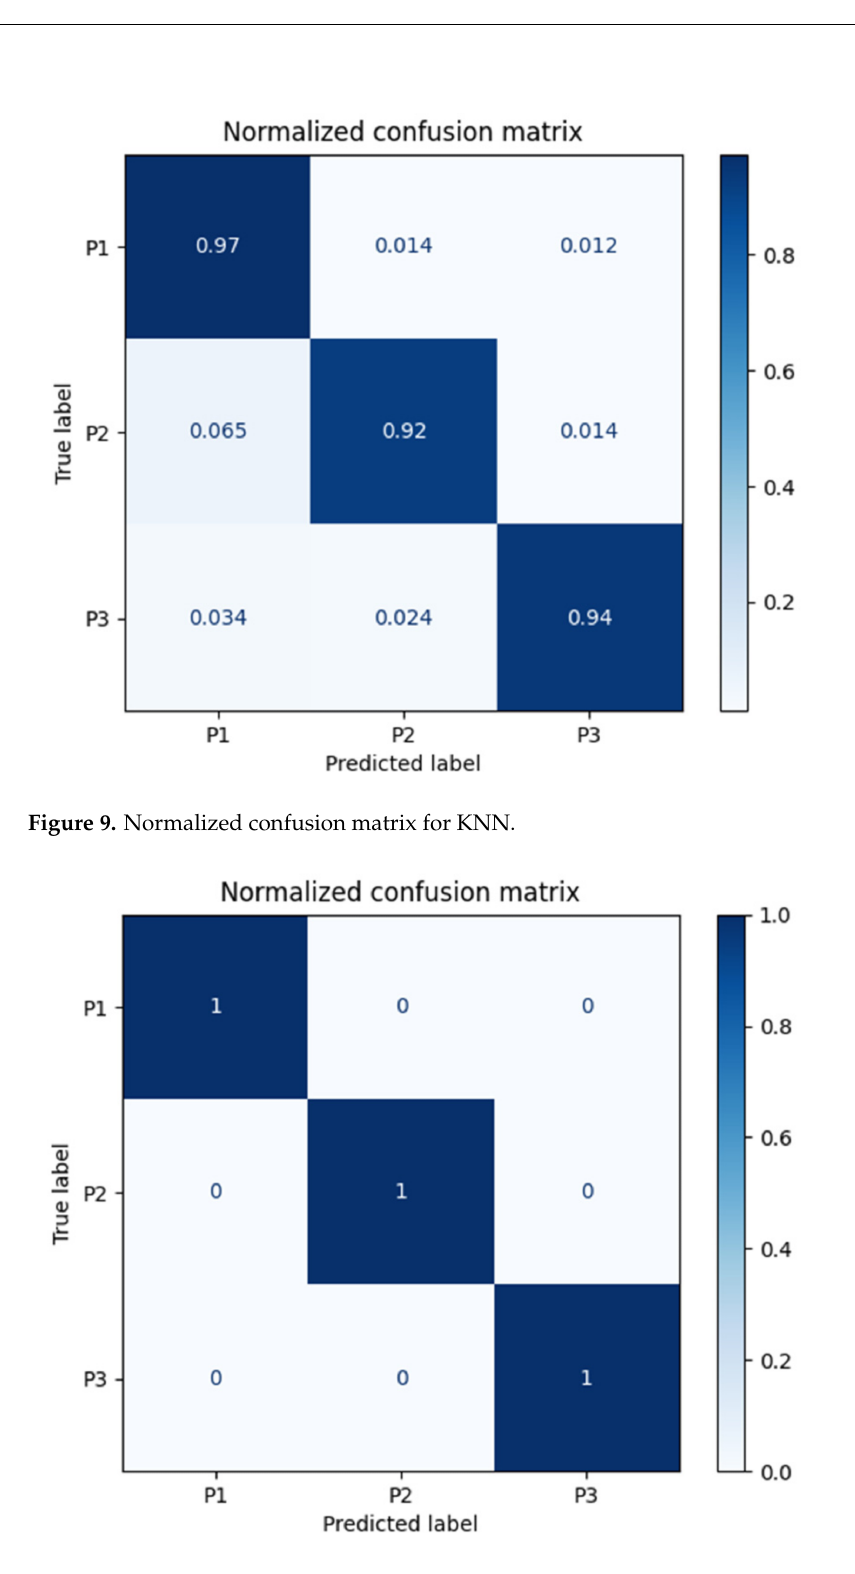
Figure 10. Normalized confusion matrix for Random